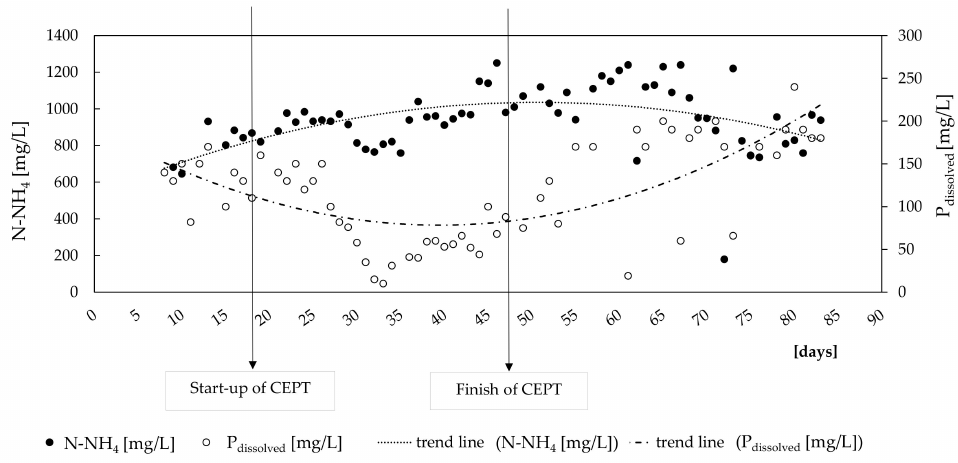
Figure 4. Changes in P dissolved and N–NH 4 in digestate during full-scale AD